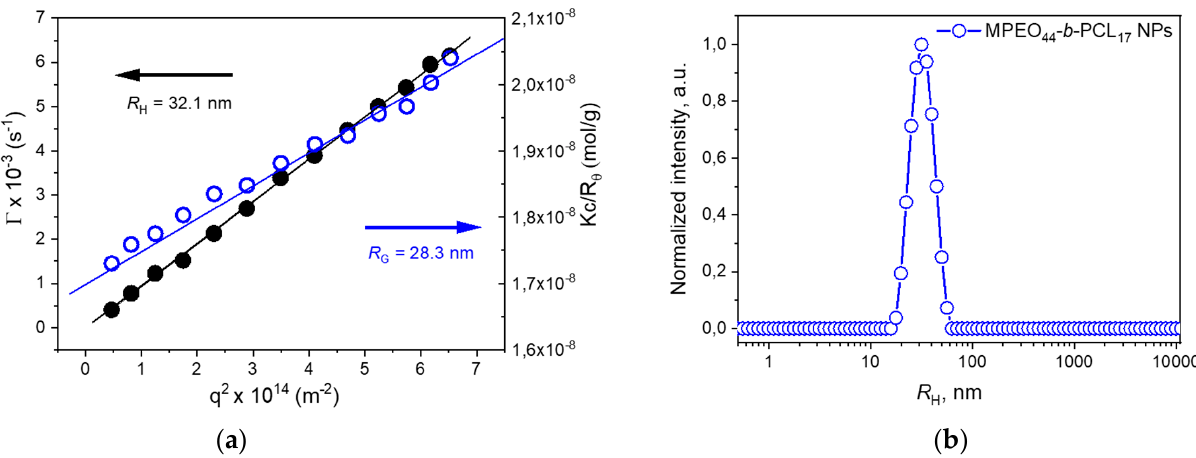
Figure 2. Measurement of angular dependence by DLS ( • ) and SLS ( ○ ) of the MPEO 44 - b -PCL 17 NPs prepared using the nanoprecipitation protocol ( a ) and normalized intensity size distribution of the MPEO 44 - b -PCL 17 NPs measured at angle 90° at a concentration of 1,0 mg·mL − 1 in PBS (pH ~ 7.4) and at 37 °C ( b ).